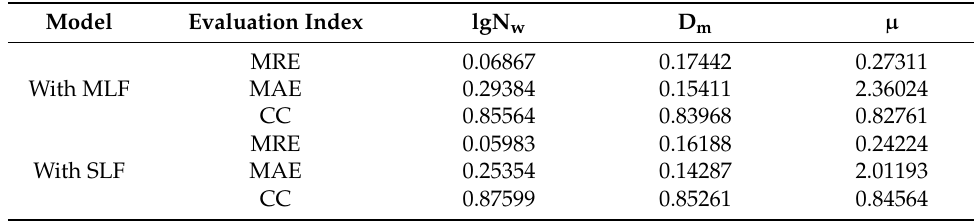
Figure 7. The 30-min scatter plot of lgN w , D m , and µ fitted by the observed data and predicted by the model, in which ( a – c ) are modeled with MLF and ( d – f ) with SLF. The red line denotes a linear trend line of the scattered points, and the color mark represents the Gaussian kernel density estimation. Table 4. The 30-min prediction evaluation results of test